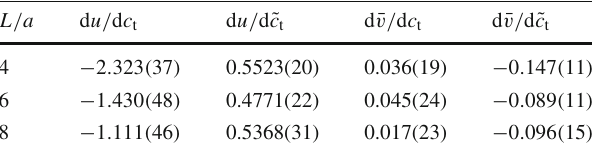
Table 9 Non-perturbative estimates for the derivatives with respect to c t and ˜ c t at u = 2 . 02. The derivatives were obtained by numerical variation of the improvement coefficients around their perturbative 2- loop and 1-loop values,